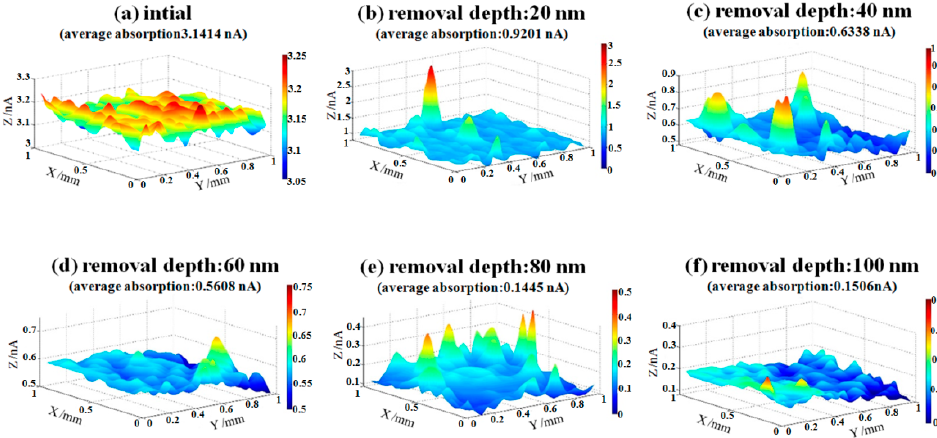
Figure 13. Weak absorption evolution of sample #2 in EJP processing.